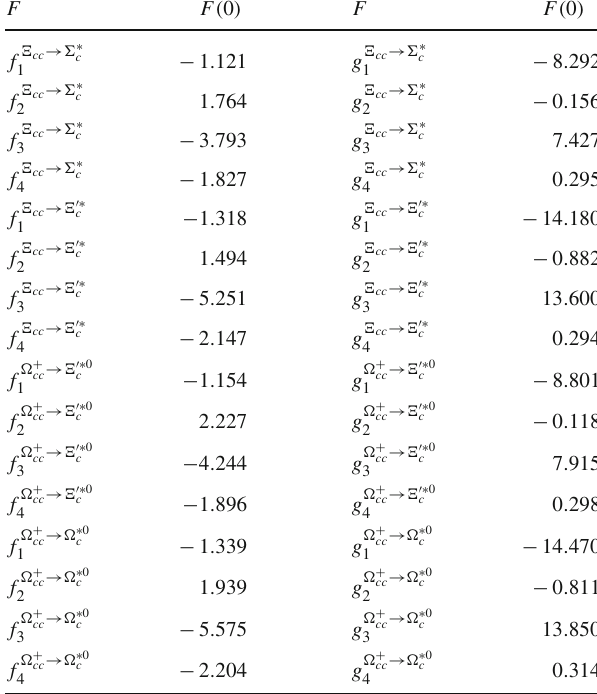
Table 6 Values of form factors at q 2 = 0 for the cc sector. The